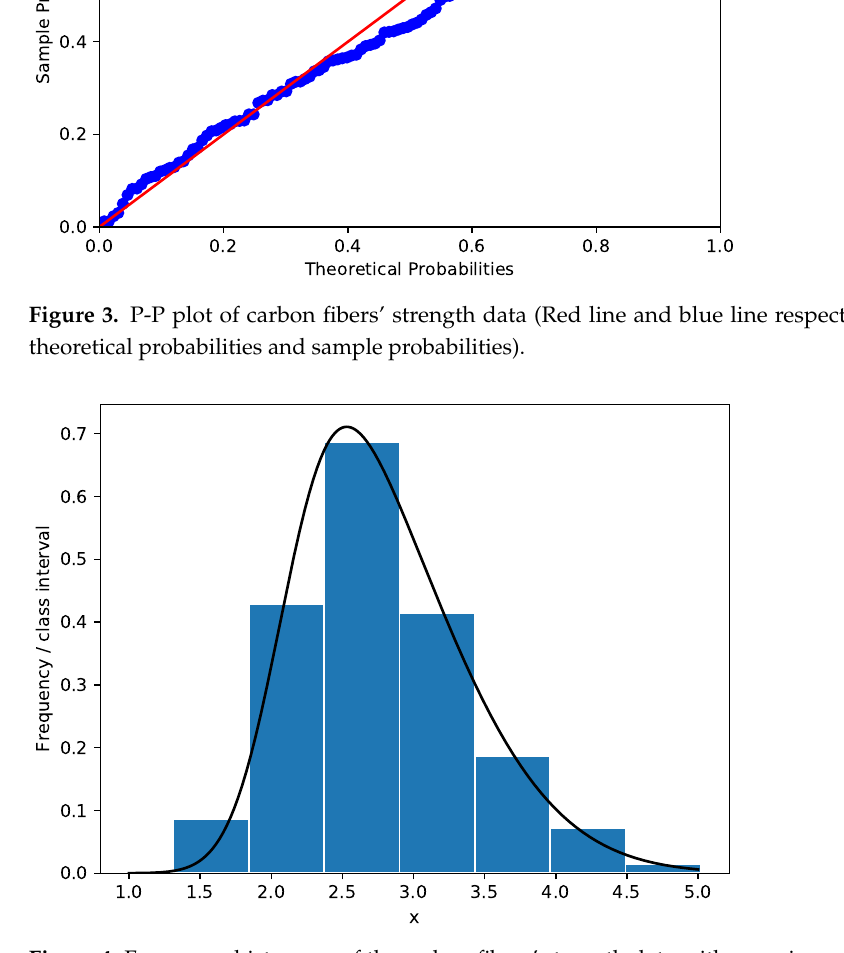
Figure 4. Frequency histogram of the carbon fibers’ strength data with superimposed skew-normal density